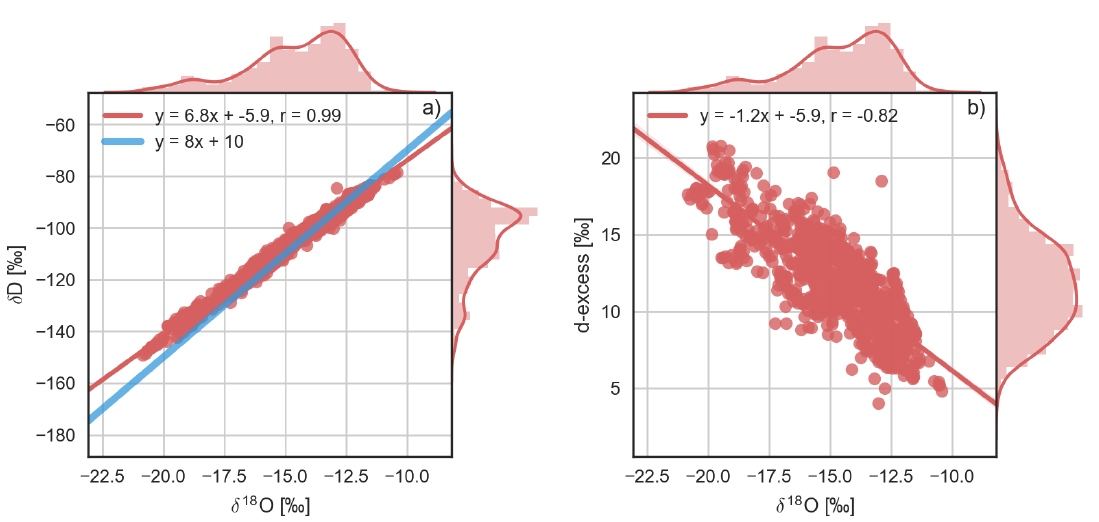
Figure 3. Distributions of ( a ) δ D and ( b ) d-excess against δ 18 O in measurements of near-surface water vapor at Gaoqiao mangrove during July 2017. The red lines indicate linear fits to the measurements based on ordinary least squares. The blue line in panel ( a ) indicates the canonical global meteoric water line